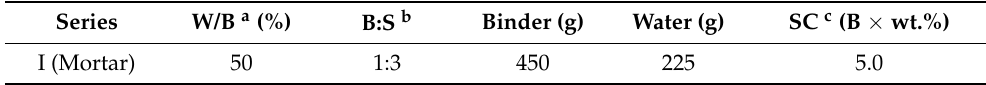
Table 3. Mix proportion of Series I (Mortar experiment).